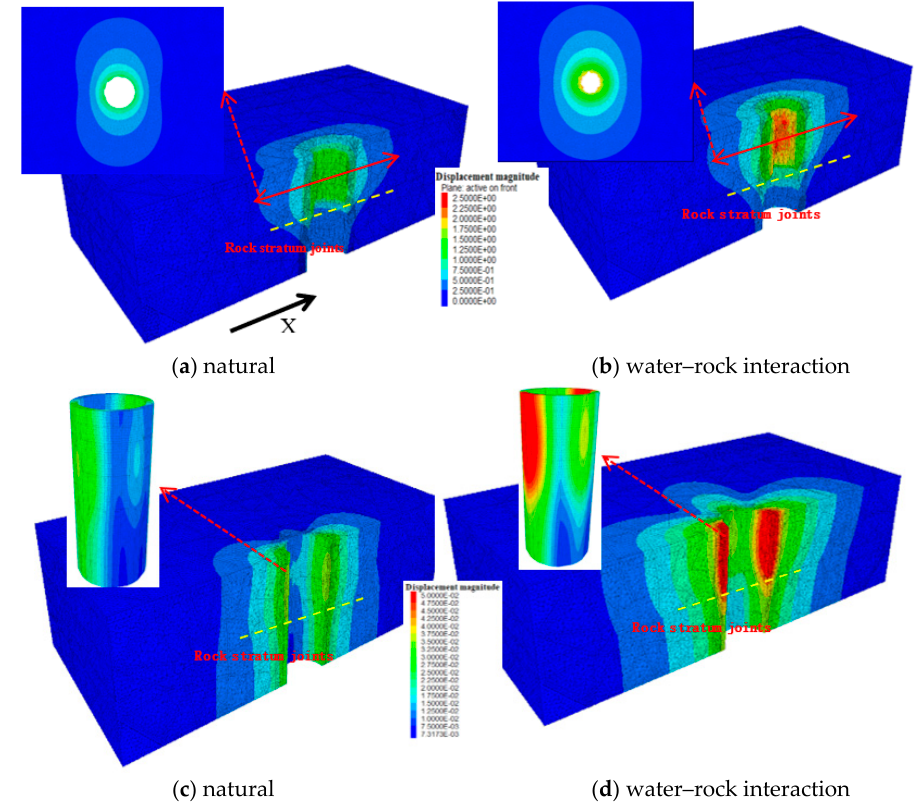
Figure 10. Simulated displacement map of the surrounding rock under unsupported conditions and under concrete supporting (C40)